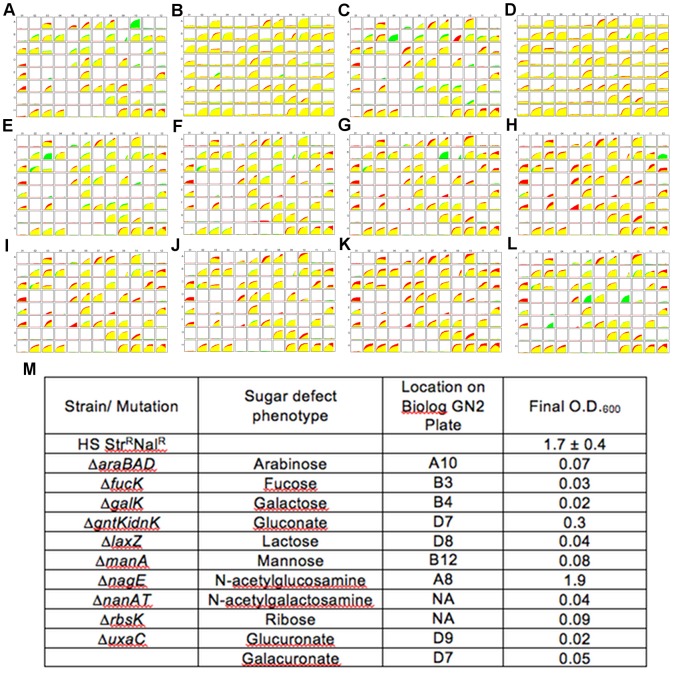
Phenotypic assay results for E. coli HS mutants.
A–L. Biolog GN2 (Gram negative carbon nutrition) plates were utilized to assess the overall metabolic capacity of the mutants constructed in E. coli HS to consume 95 individual carbon sources (see Materials and Methods for details). The kinetic curves plot substrate oxidation vs. time. Green represents carbon source utilization by the E. coli HS wild type strain, red represents the mutant strain, and yellow represents utilization by both strains. Mutant strains of E. coli HS: (A) ΔaraBAD, (B) araBAD+, (C) ΔgalK, (D) galK+, (E) ΔfucK, (F) ΔgntK ΔidnK, (G) ΔlacZ, (H) ΔmanA, (I) ΔnagE, (J) ΔnanAT, (K) ΔrbsK, and (L) ΔuxaC. M. Sugar utilization was assessed in minimal media containing 0.2% carbon source. The final O.D.600's following 12 hour incubations are shown. Note: the generation time of E. coli HS ΔnagE on N-acetylglucosamine is 2.6 h compared to 1 h for the wild type (see text for details). The sugars N-acetylneuraminate and ribose are not represented on the Biolog plate (NA).